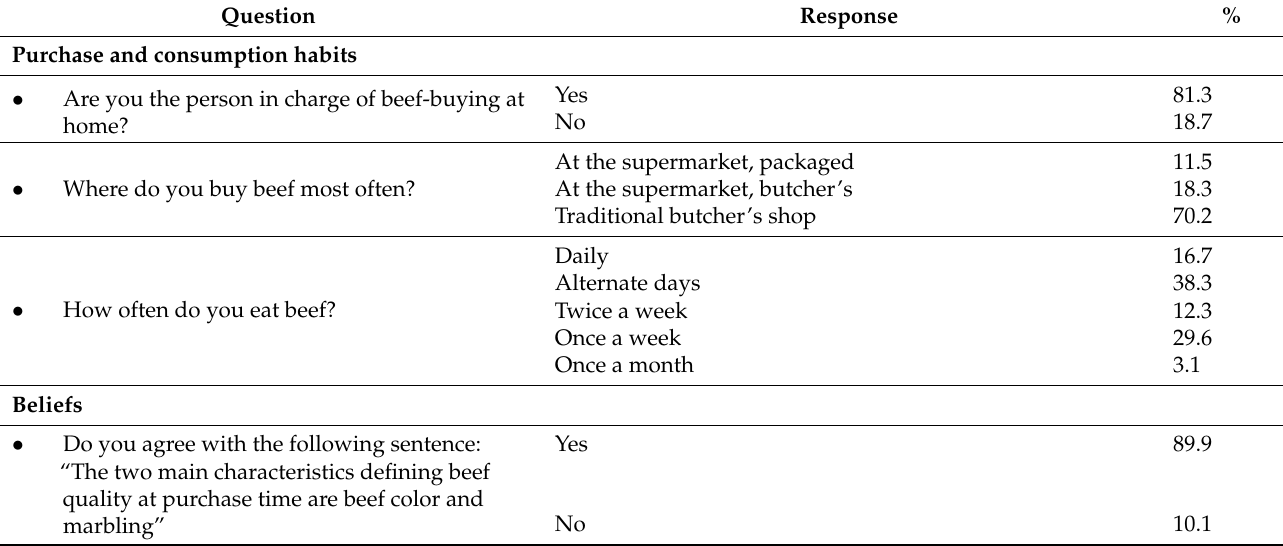
Table 2. Survey questions and answers of purchase habits, beliefs, and choice behavior. Results are percentages of valid